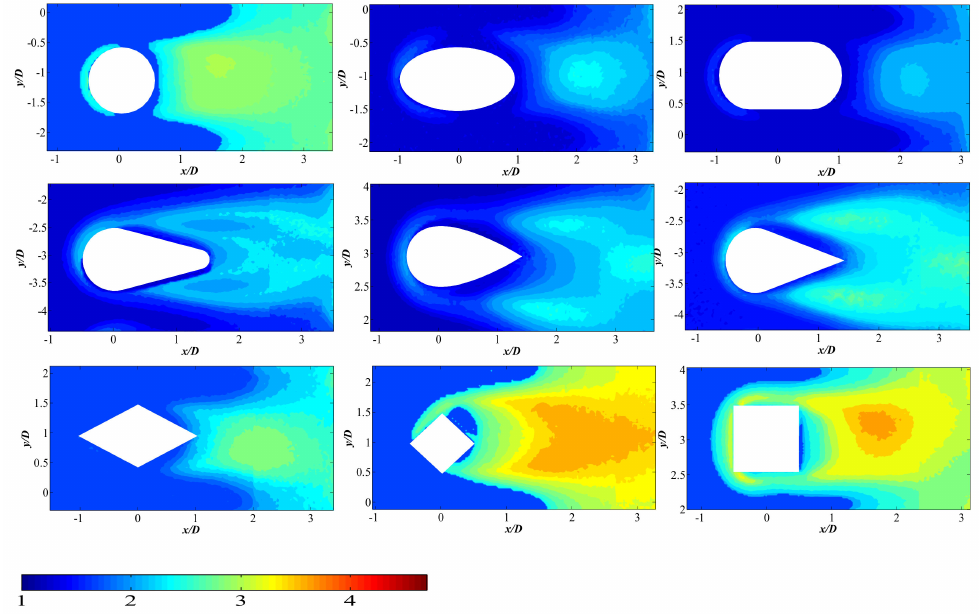
Figure 10. Nu / Nu 0 distribution comparison, Row1, Re =